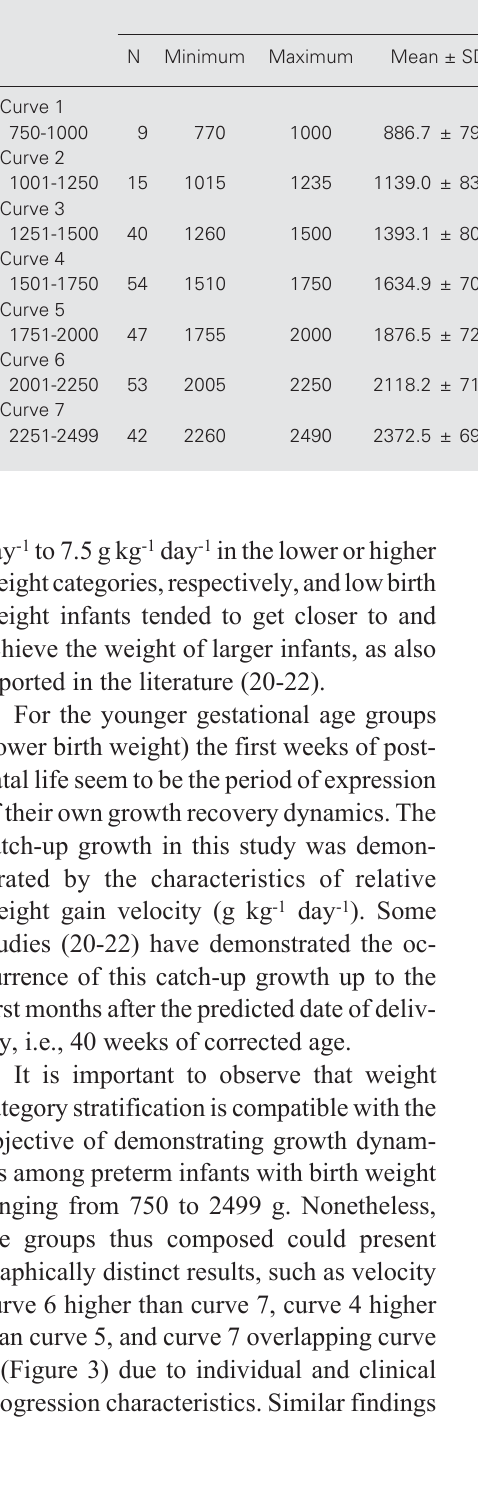
Table 1. Distribution of adequate-for-gestational-age preterm newborns by weight category and gestational age at birth. Birth weight